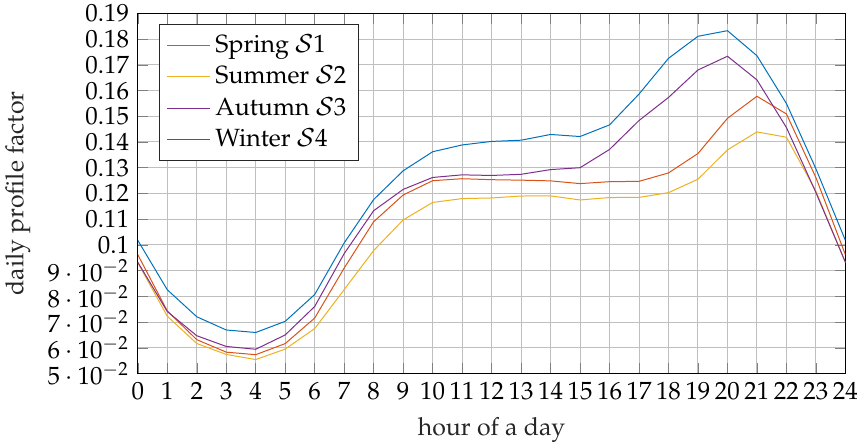
Figure 1. Daily load profile for Spring ( S 1), Summer ( S 2), Autumn ( S 3) and Winter ( S 4).